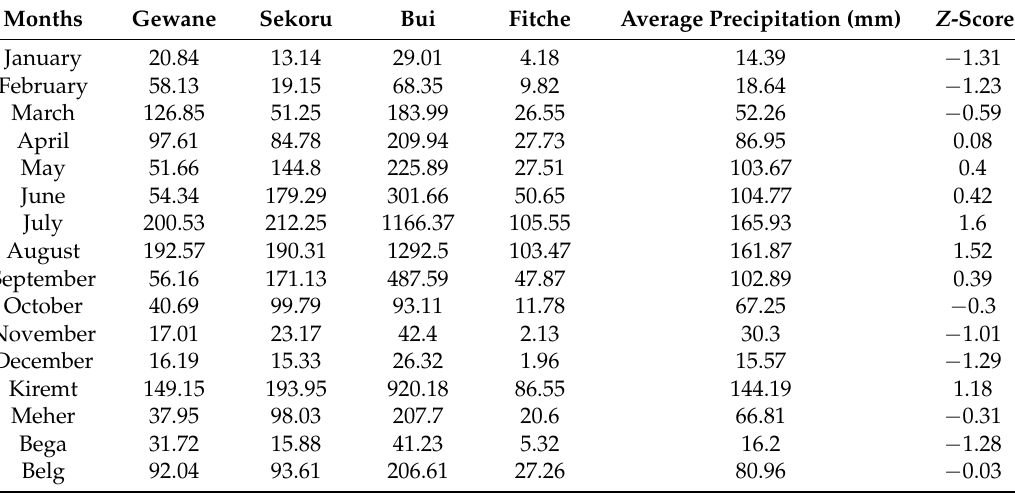
Table 3. Monthly and seasonal precipitation of